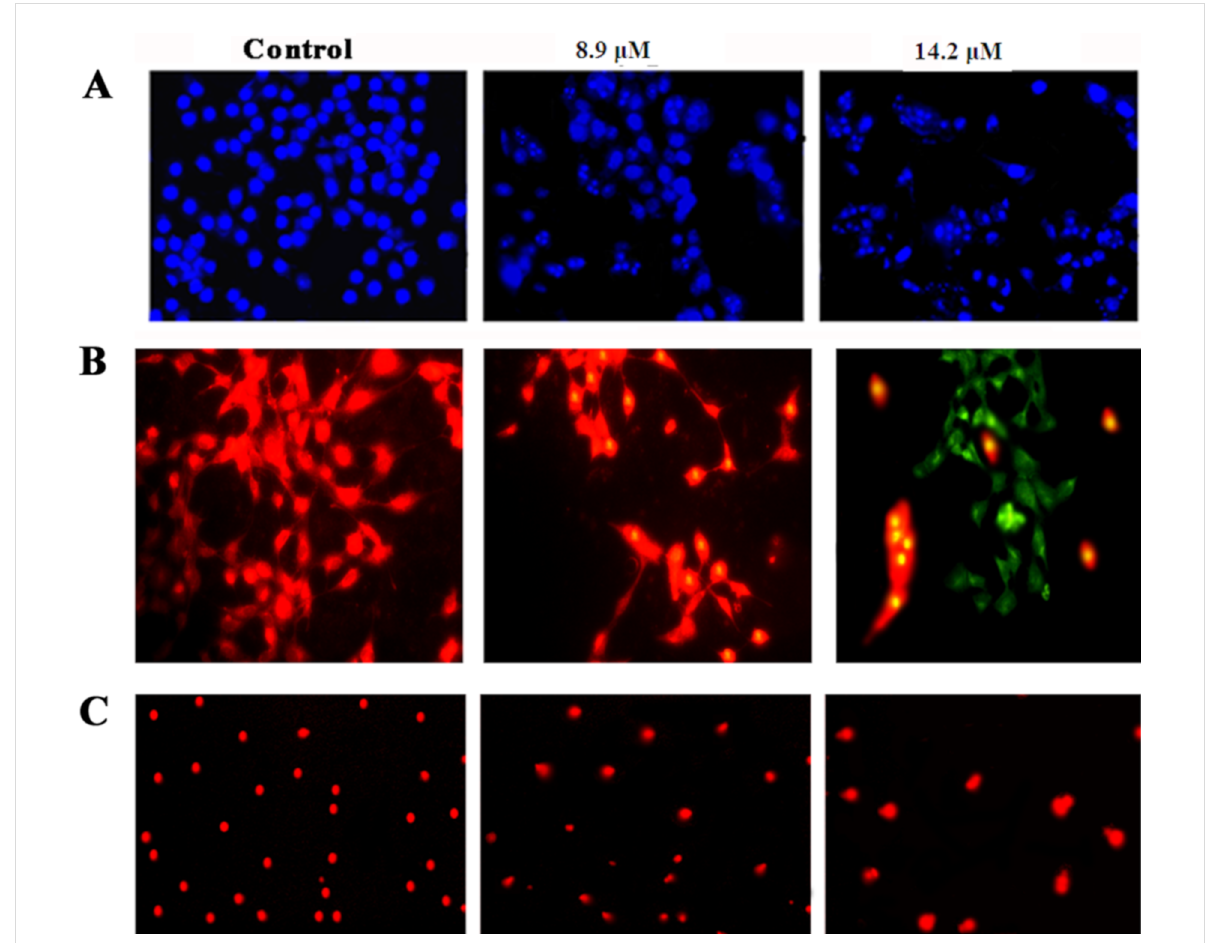
Figure 6: Fluorescence microscopic images of 11b at different concentrations (8.9, and 14.2 µM, respectively) of the HeLa cells after 24 h treatment. HeLa cells with (A) DAPI staining, (B) JC-1 probe and (C) comet assay revealed significant change in control and treated conditions.